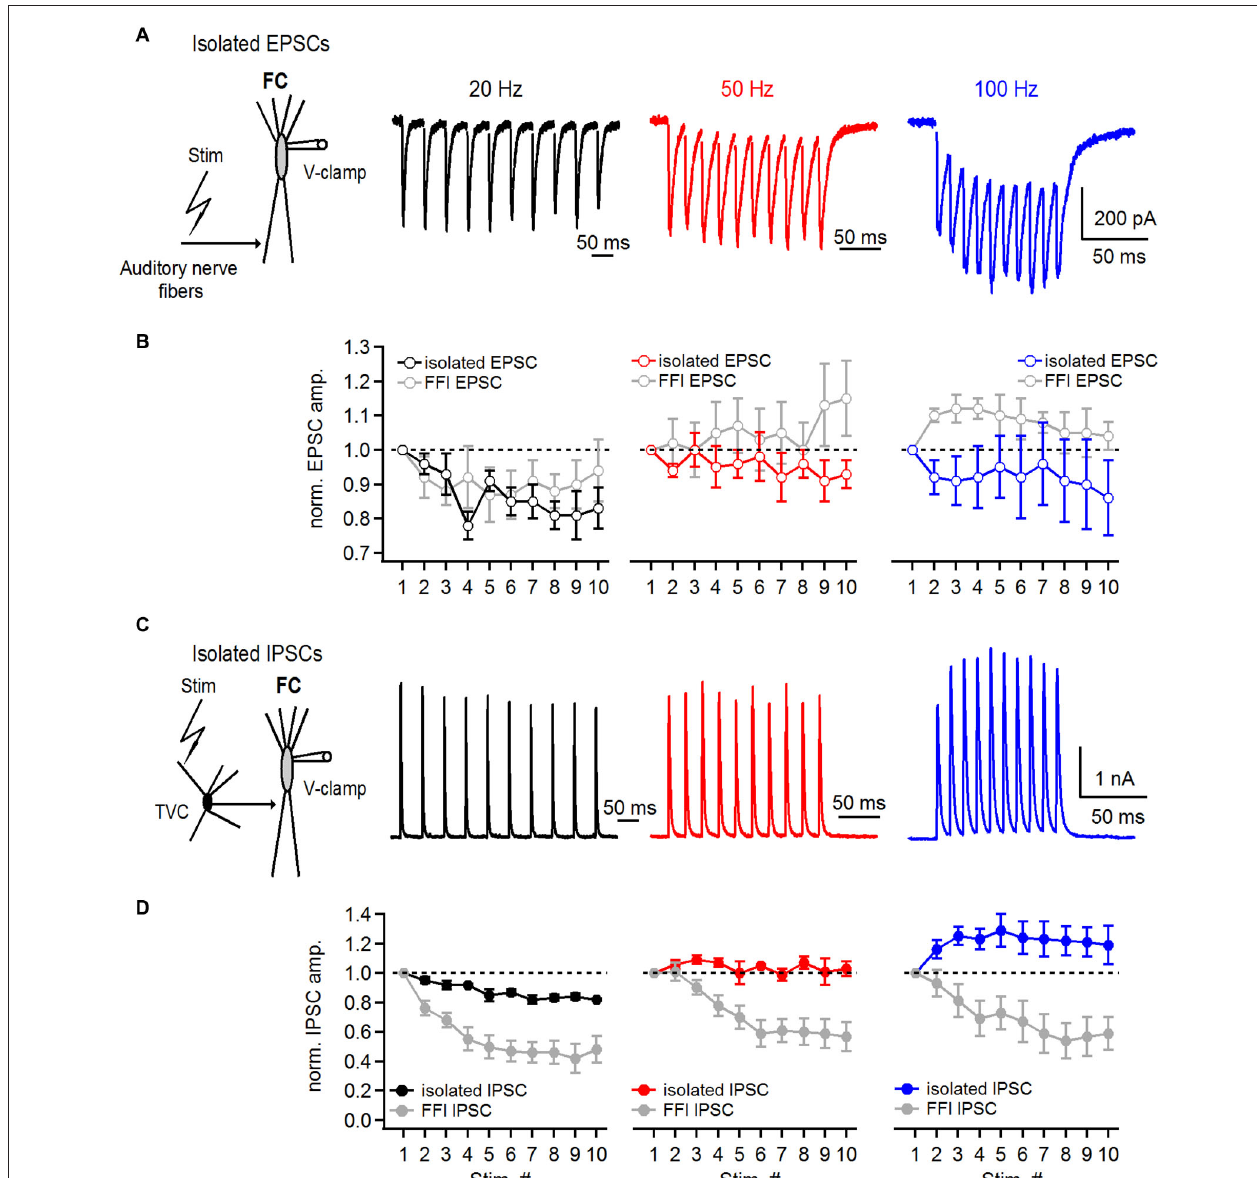
a fusiform cell evoked by direct stimulation of inhibitory inputs in the deep layer of the DCN at 20, 50 and 100 Hz. Schematic drawing in the left shows the experimental protocol. All recordings were done in 20 µ M DNXQ and 5 µ M R-CPP to block excitatory transmission. (D) Plots of IPSC amplitudes in the train normalized to the first IPSC at corresponding frequencies of stimulation of inhibitory inputs. Gray data of IPSC short-term plasticity recorded during feed-forward inhibition trials and shown in Figure 4 are included for comparison. Differences in short-term plasticity of directly stimulated IPSCs and those evoked during FFI were statistically significant ( P < 0.001, n = 6 cells). All stimulation artifacts in A and C were removed for clarity. Traces represent averages of 5–10